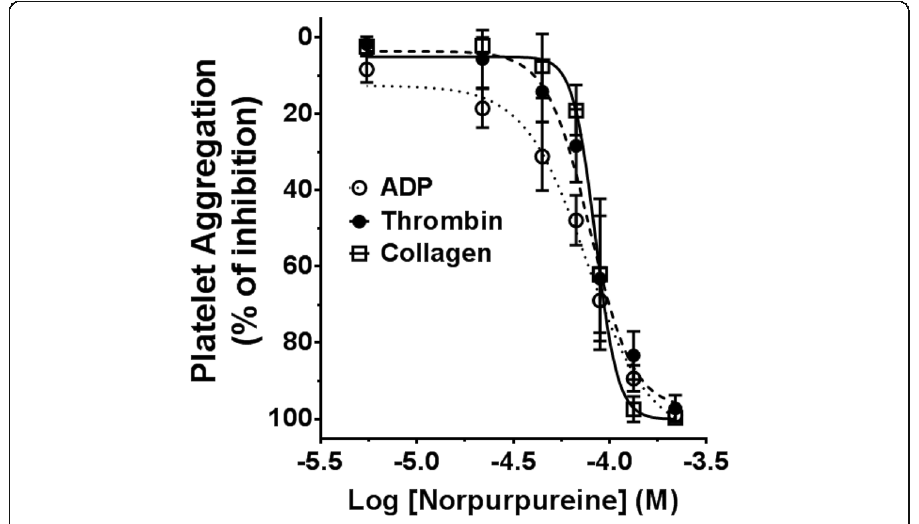
Fig. 3 Potency of norpurpureine as an anti-platelet agent. Concentration – response curves for norpurpureine inhibitory actions on agonist-induced platelet aggregations were constructed. Each data point, mean ± SD ( n = 5), is presented as the percentage reduction of the maximal amplitude response (versus the control, in the absence of norpurpureine). All measures were taken 10 min after the addition of the